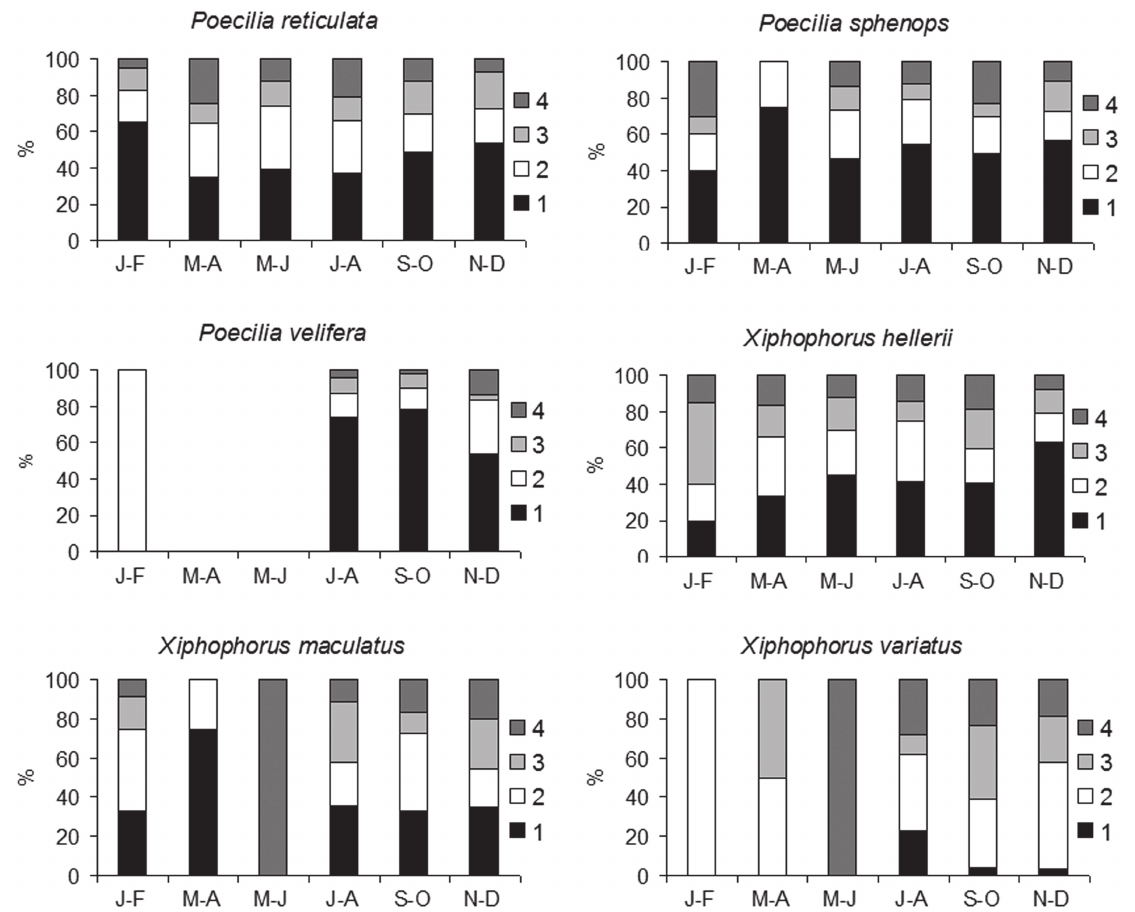
Fig. 4. Relative bimonthly frequency of developmental stages in ornamental non-native poeciliid females collected in Santo Antônio Creek, 2005. Developmental stages: 1 Non-gravid, 2 Yolked ova, 3 Eyed embryos, 4 Mature